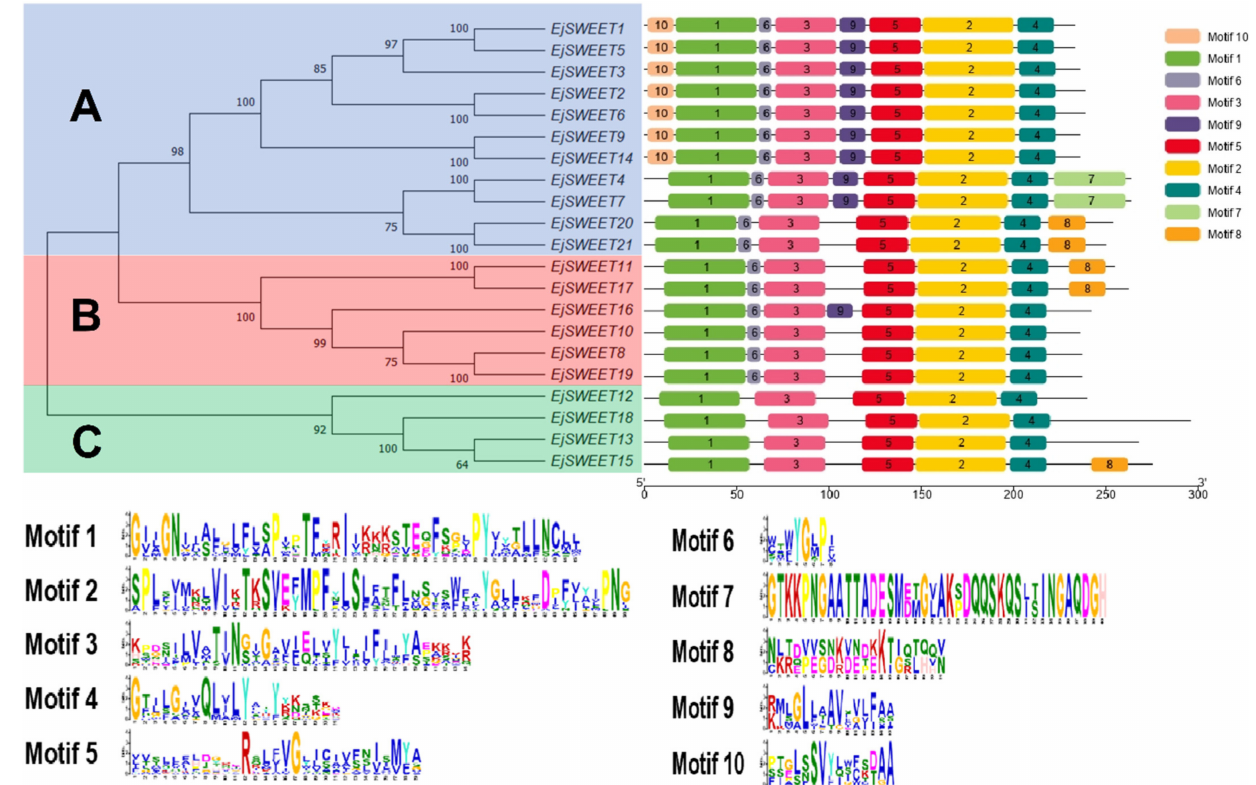
Figure 2. Phylogenetic relationship and conserved motif analysis of EjSWEET